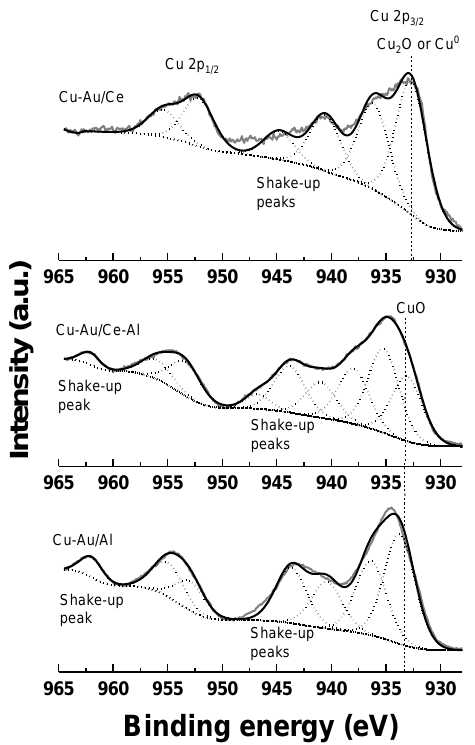
Figure 6. Cu 2p spectra of all Cu-containing catalysts.